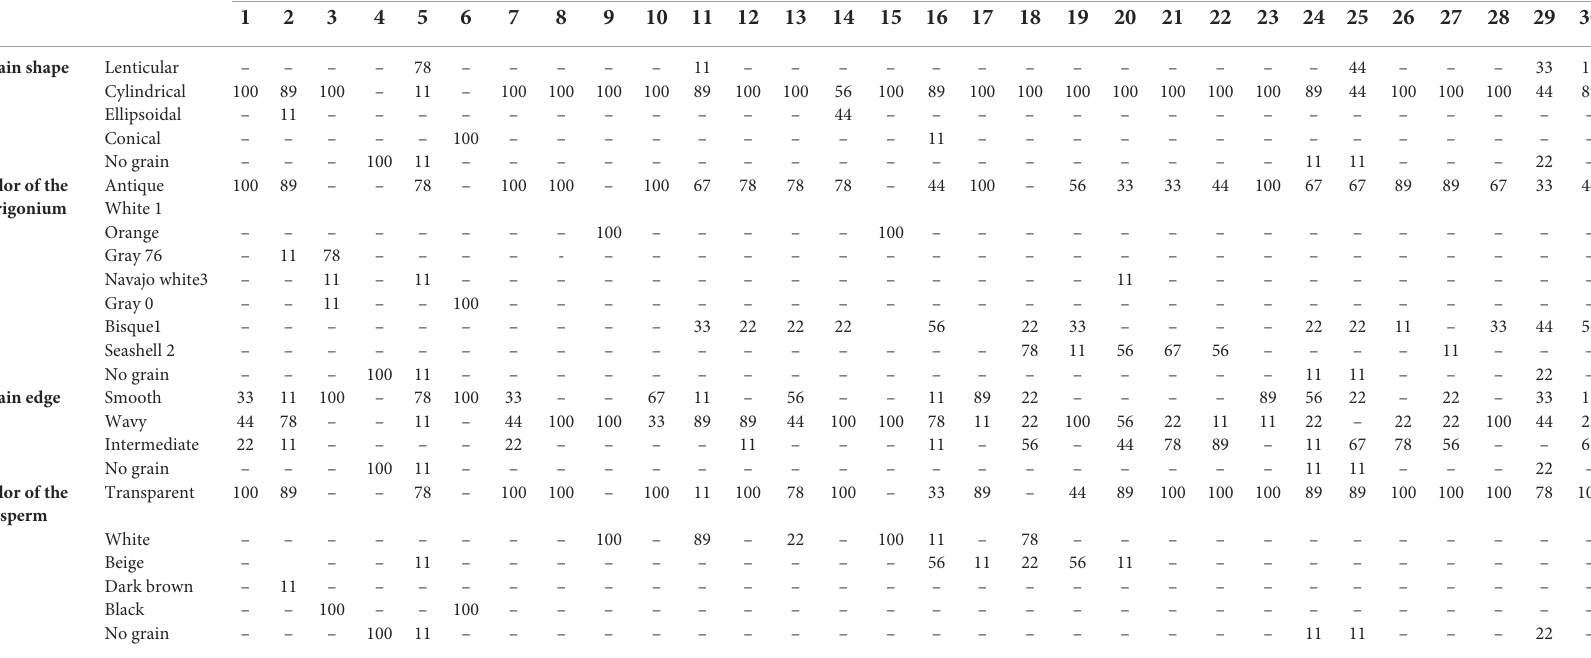
TABLE 6 Qualitative descriptors used in the characterization of 30 quinoa